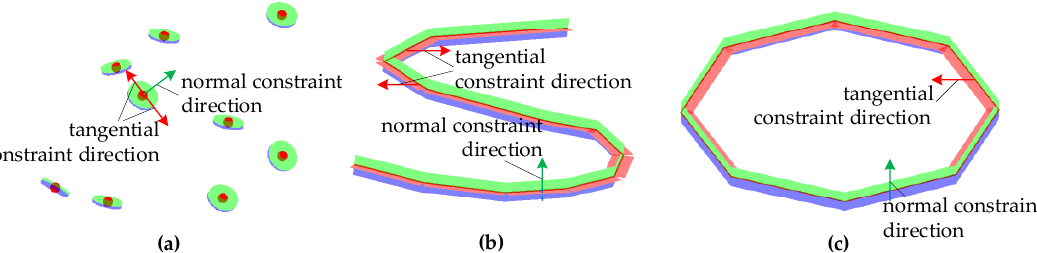
Figure 3. Constraint data for implicit modeling. ( a ) shows the constraint points. ( b ) shows the non-boundary constraint polyline. ( c ) shows the boundary constraint polyline.